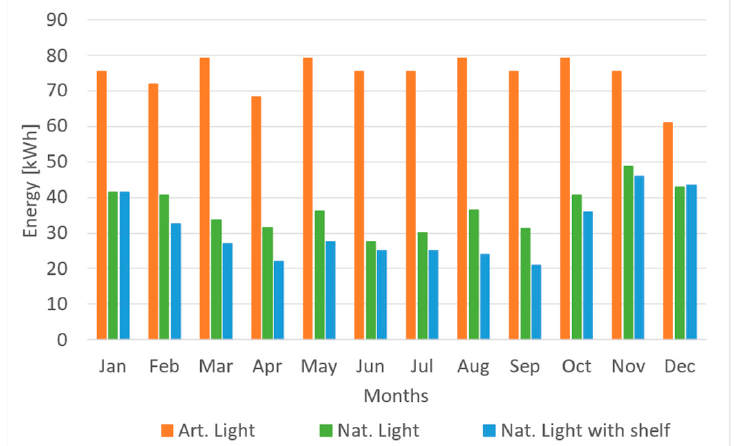
Figure 9. Monthly electrical energy consumption tendency: (orange) without regulation, (green) using natural light without a light shelf, (blue) using natural light with a light shelf (south-facing window) [12].